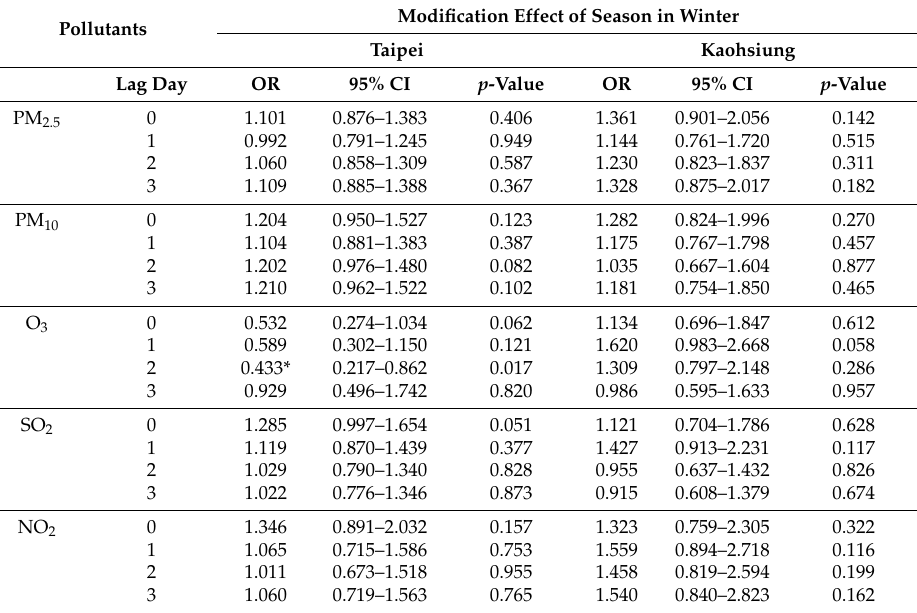
Table 7. Association between air pollution and childhood asthma in